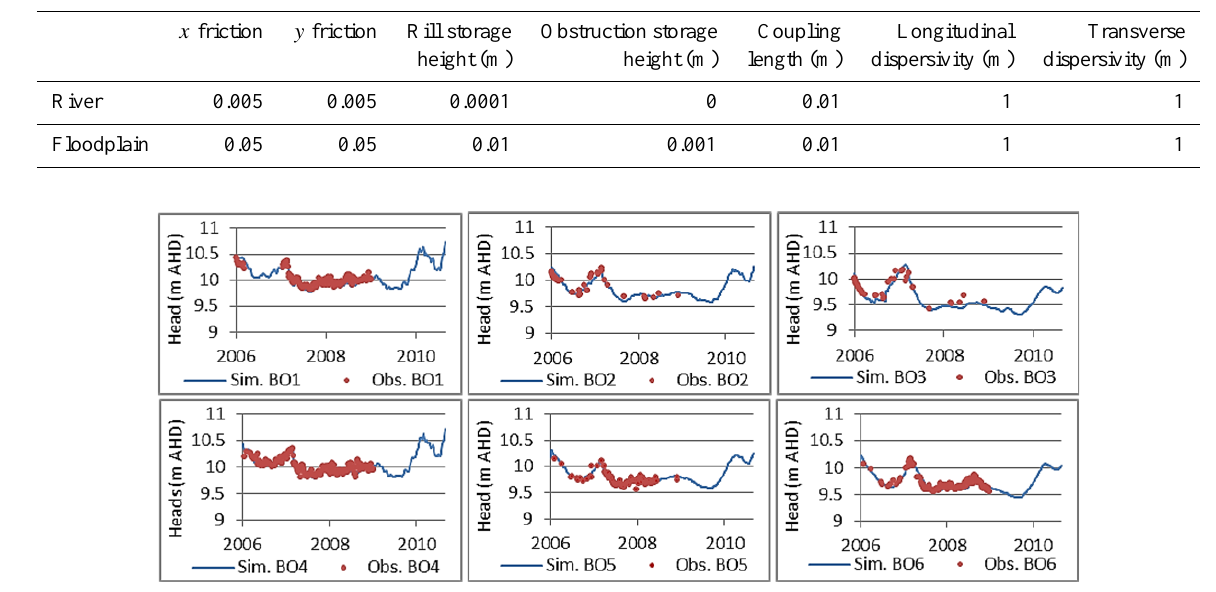
Fig. 5. Simulated and observed groundwater heads at observation wells.